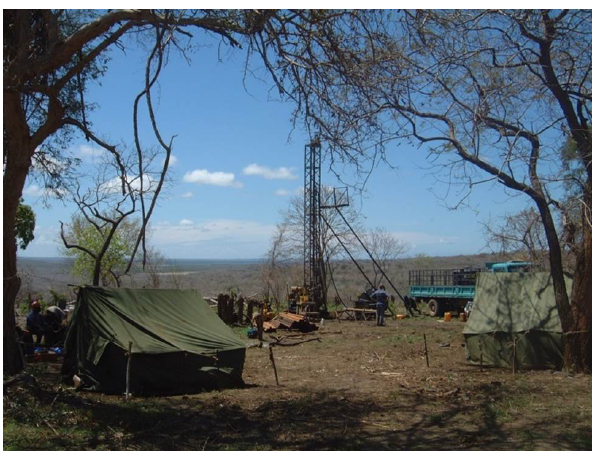
Figure 4. One of 40 shallow penetration boreholes drilled by the Tanzania Drilling Project (2002–2009). This is TDP site 12, the pro- posed TOPIC drill site (see Fig. 1 for